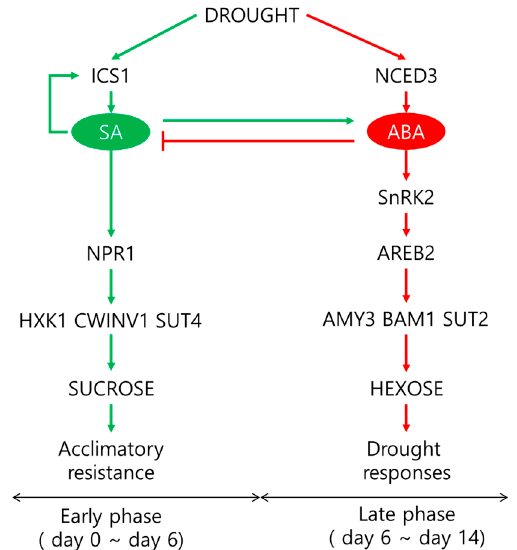
Figure 8. Proposed model of crosstalk between SA, ABA, and the sugar metabolism in two distinct phases of drought intensity. Green and red arrows represent the SA- and ABA-dependent pathways, respectively, in response to drought.